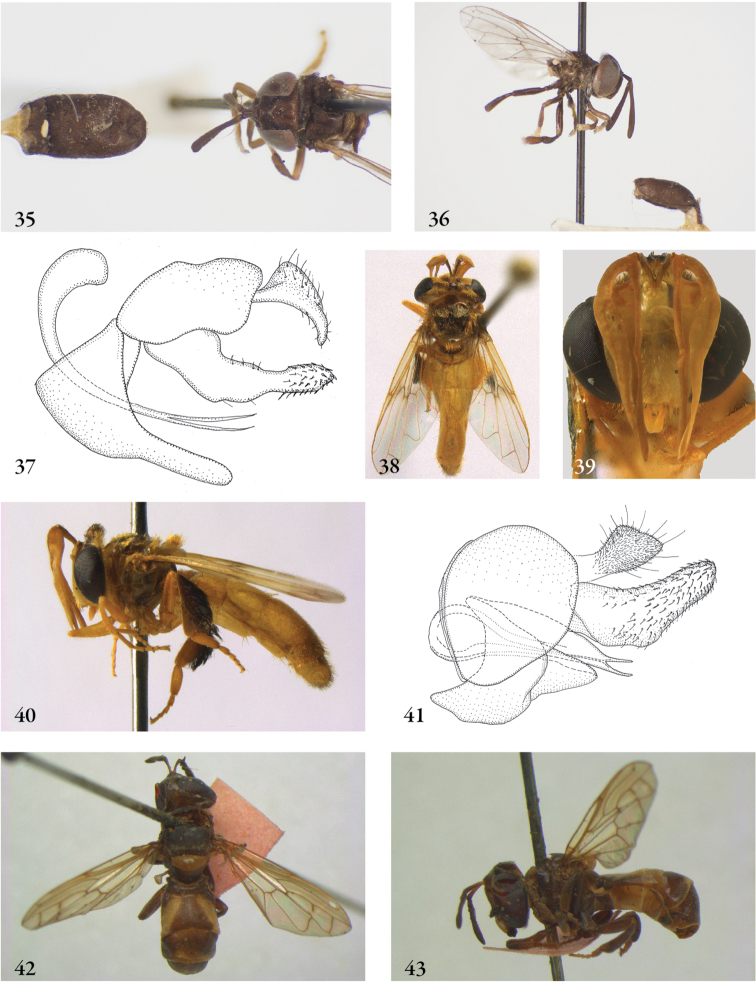
35–37
Bardistopus papuanum male (holotype): 35 habitus dorsal 36 habitus lateral 37 genitalia lateral 38–41
Carreramyia megacephalus male (Costa Rica, coll. M. Hauser): 38 habitus dorsal 39 head frontal 40 habitus lateral 41 genitalia lateral (Costa Rica, coll. RMNH) 42–43
Ceratophya notata male (holotype): 42 habitus dorsal 43 habitus lateral.